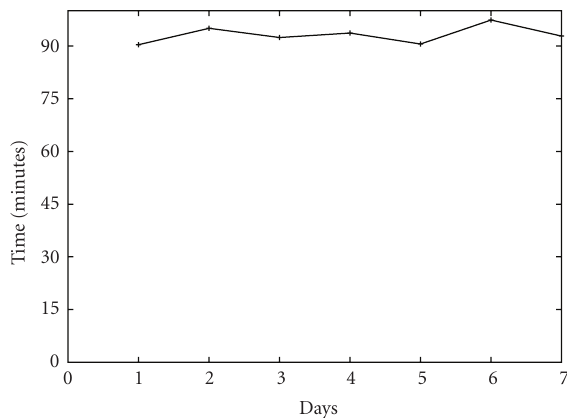
Figure 13: Processing time of repeated sequence detection on each day of TVTest . For each day, a sliding accumulated TV stream of 7 days has been taken into